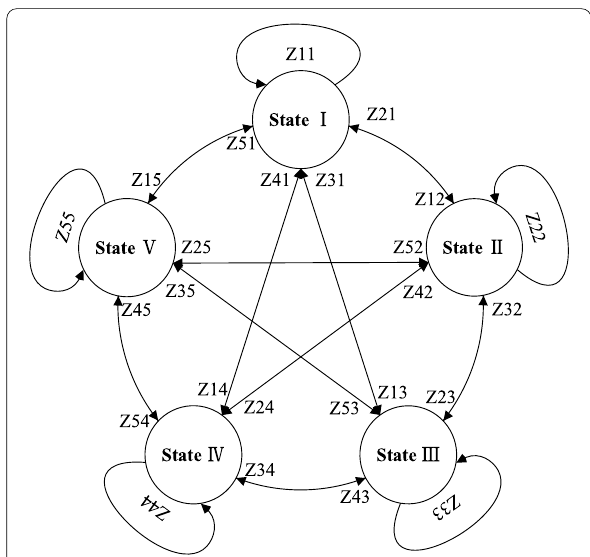
Figure 5 Diagram of state transition of residual error value of centroid